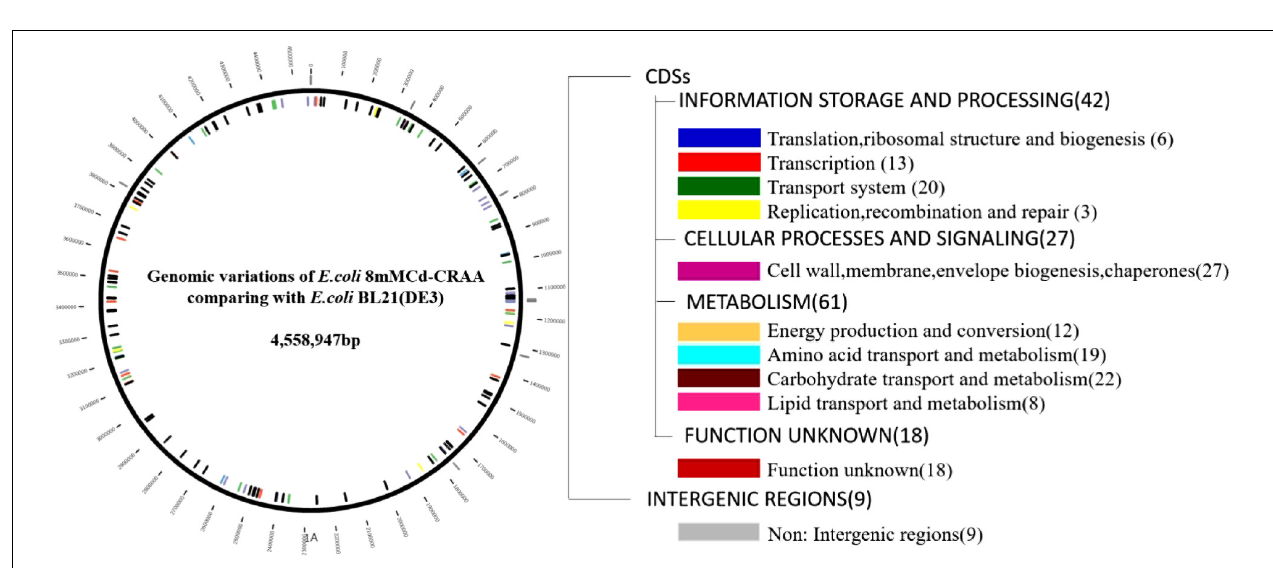
FIGURE 7 | The effects of Gor mutations and growth curves of BL21 (cid:49) gor with cadmium and GSH. (A) The effects of Gor mutations. A wild-type Gor strain was used as a control; ∗ p < 0.05; ∗∗ p < 0.01. (B) Growth curves of BL21 (cid:49) gor with cadmium and GSH. (cid:49) Represents gene deletion.